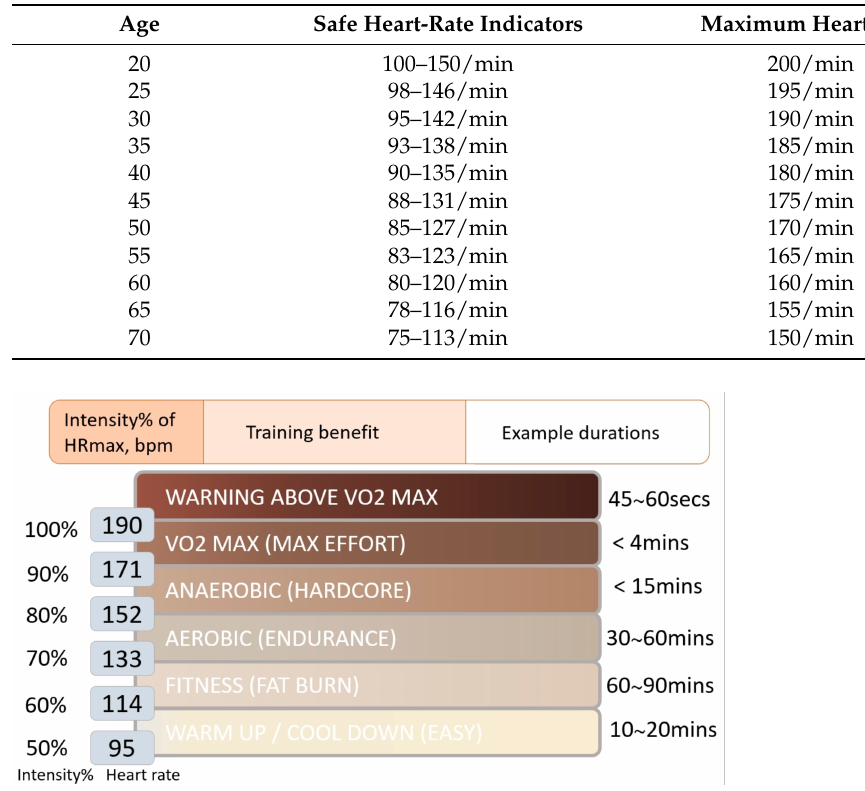
Table 4. Safe heart-rate indicators and maximum heart rates for persons aged 20–70 years old.